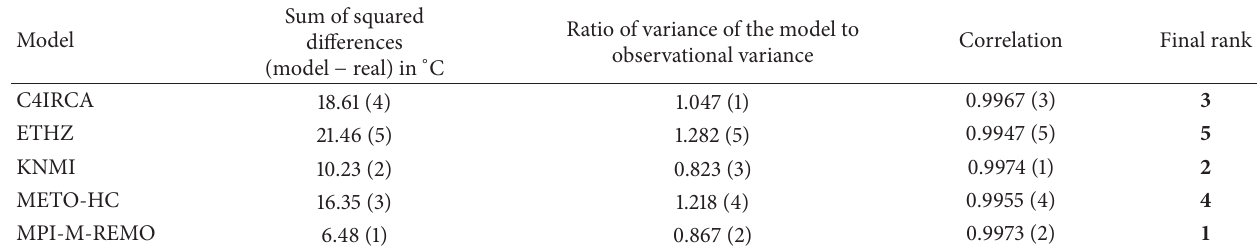
Table 1: Comparison of modelled and observed temperature for the city of Poznan referring to second-order statistics: sums of squared differences, ratios of variances, and correlation coefficients (corresponding rank in brackets) and the final ranks for the models based on the temperature.